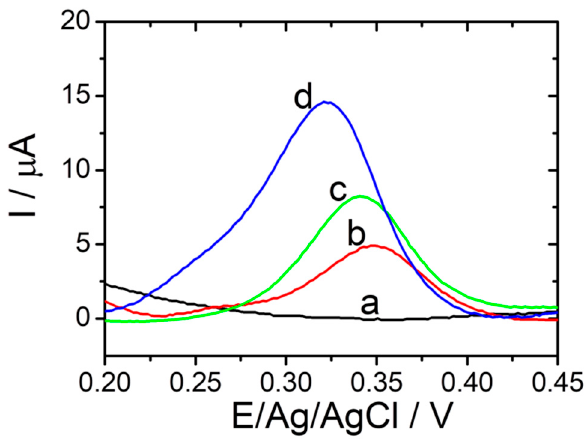
Figure 3. DPVs performed in PBS in the absence of PyoV for reduced graphene/graphite SPE modified with AuNPs (black (a)), and performed in 100 µ M PyoV in PBS for bare graphene/graphite SPE (red (b)); reduced graphene/graphite SPE (green (c)), and reduced graphene/graphite SPE with AuNPs (blue (d)) (20 mM PBS pH 7.4; from − 0.3 to +0.8 V vs. Ag/AgCl; 0.02 V·s − 1 ).